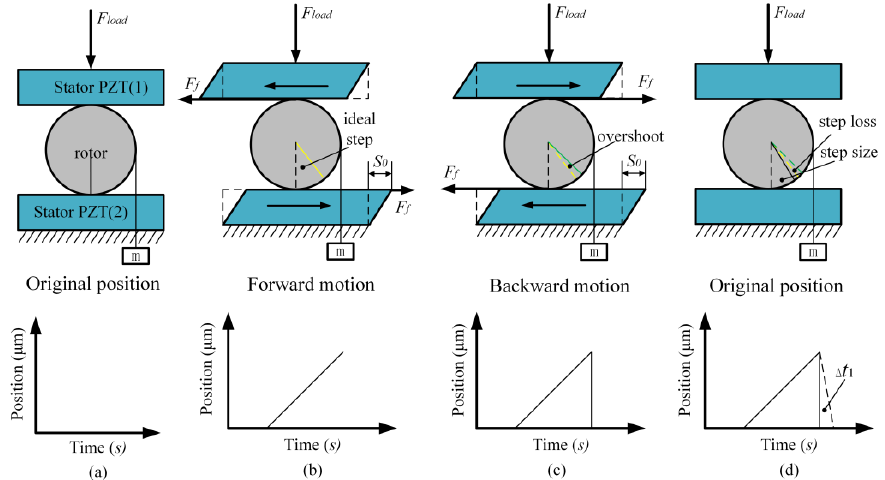
Figure 3. The schematic of the motor motion mechanism with external loads. ( a ) Initial position; ( b ) Sticking phase; ( c ) Slipping phase; ( d ) Overshoot.